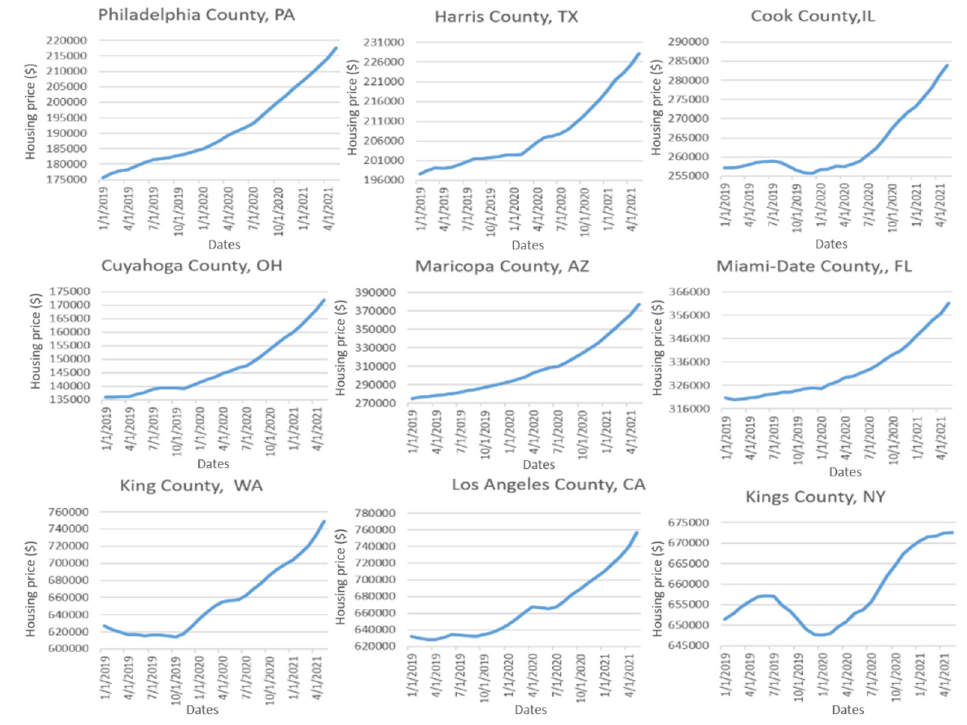
Figure 2. Examples of housing price changes from 1 January 2019 to 31 May 2021.